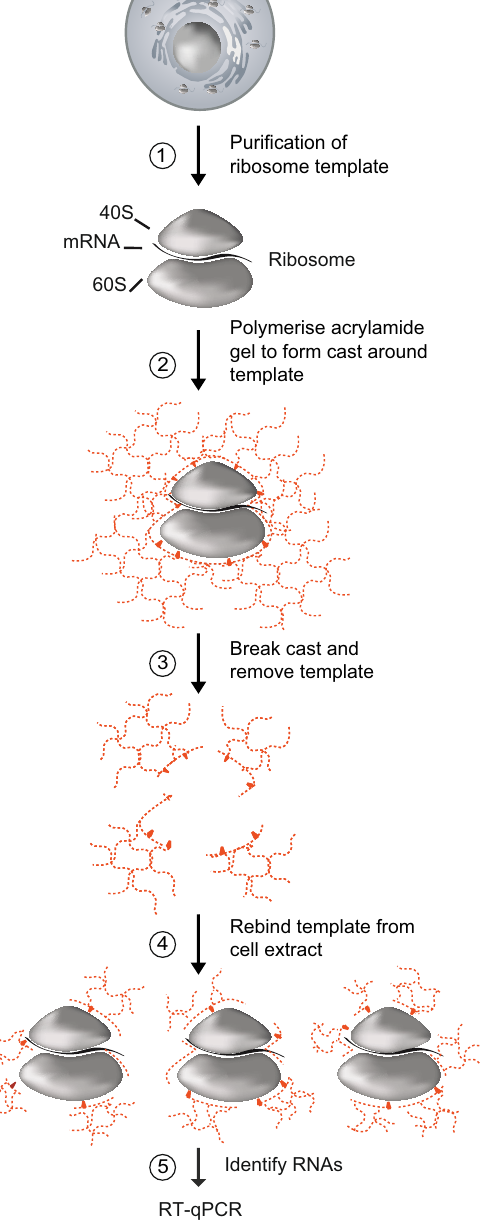
Figure 1. Schematic overview of R-MIP preparation. First, ribosomes are isolated from HeLa cell cytoplasmic extract using a sucrose cushion. Second, the ribosome template is combined with a mixture of acrylamide (AA) and N , N ′ -methylenebisacrylamide (MBAm) monomers, and polymerisation is induced under gaseous nitrogen upon addition of the initiator ammonium persulfate (APS) and the catalyst N , N , N ′ , N ′ - tetramethylethylenediamine (TEMED). Third, the hydrogel is granulated by passing through a sieve mesh, and the ribosome template is removed from the MIP. This results in a slurry of heterogeneous PAA fragments, with cavities possessing the potential to recognise more template, based both upon three dimensional structure and direct interactions between the template and chemical groups on the surfaces of the cavities. Fourth, MIPs are combined with cellular extracts to capture ribosomes and associated mRNAs. Fifth, ribosome-associated mRNAs are isolated from the MIP for further analysis, such as reverse transcription (RT)-quantitative PCR